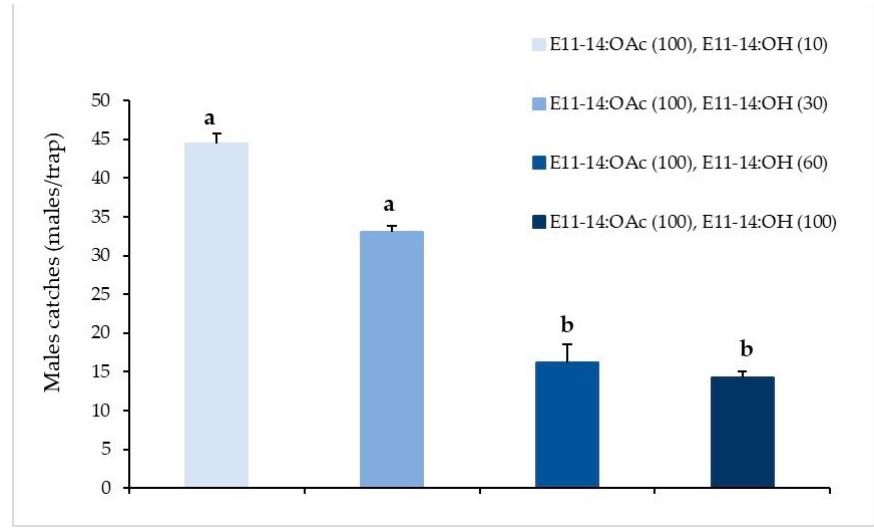
Figure 2. Male P. auraria cumulative catches (avg. ± SE) in traps ( n = 4) loaded with different ratios of E11-14:OAc and E11-14:OH. Nancagua, central Chile, 18–25 February 2015. Different small letters above a column mean significant differences between treatments. Figures in parenthesis represent μ g/septa.